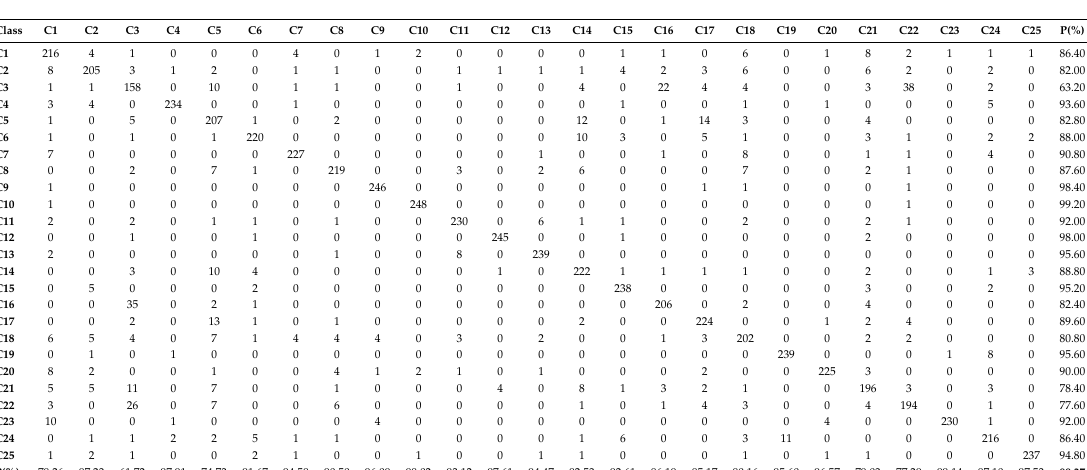
Table 8. Confusion matrix of classification results based on